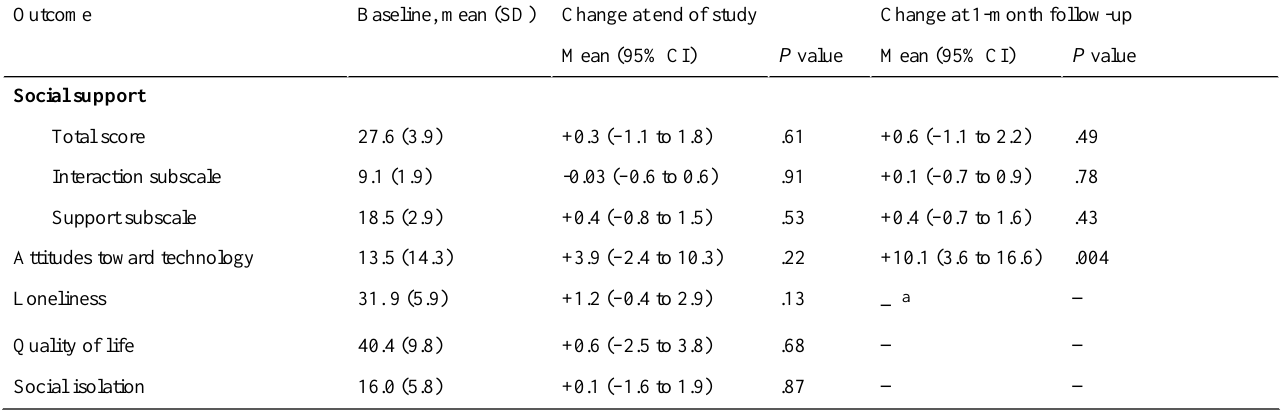
Table 2. Quantitative outcomes at baseline, end of study, and follow-up.